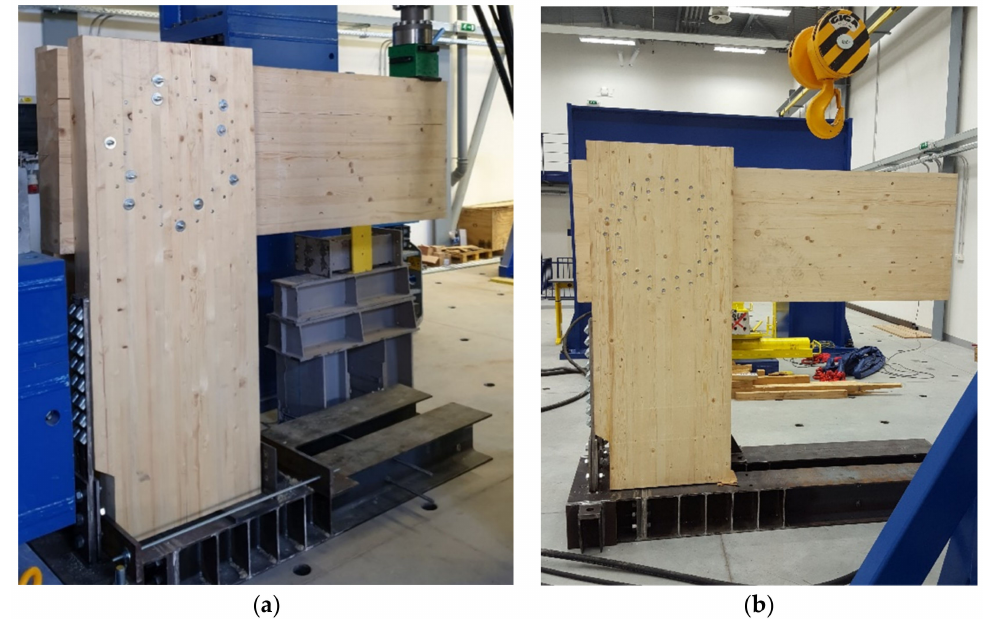
Figure 17. Experimental sample: ( a ) test sample no. 4; ( b ) test sample no.